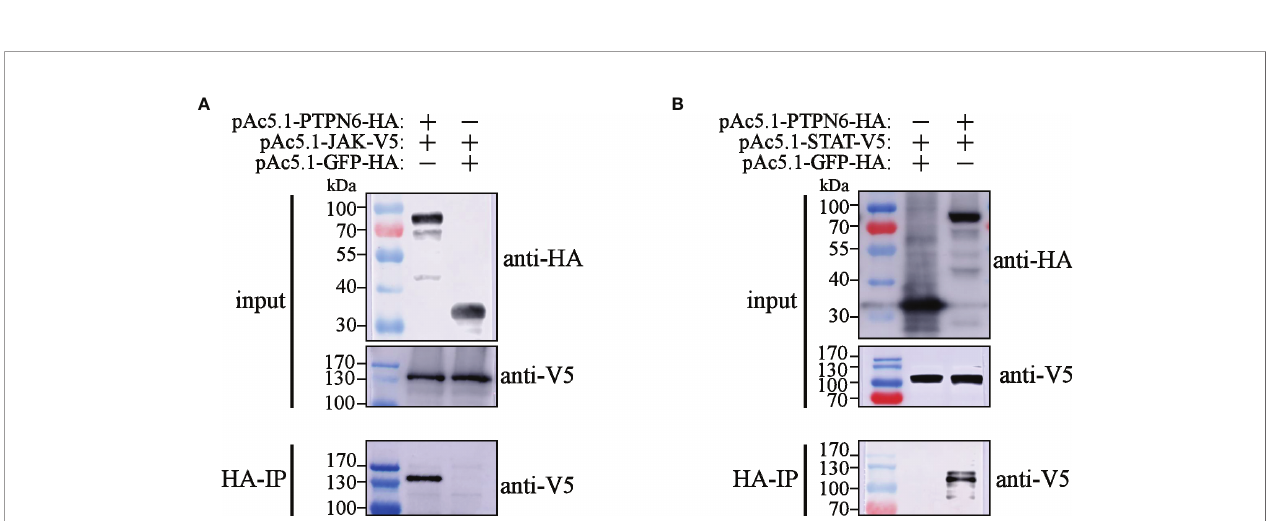
FIGURE 6 | Co-IP analysis of the interaction between LvPTPN6 and JAK/STAT. Interaction between HA-tagged LvPTPN6 and V5-tagged JAK (A) or STAT (B) , HA- tagged GFP was set as internal control. Interacted proteins were precipitated by anti-HA af fi nity